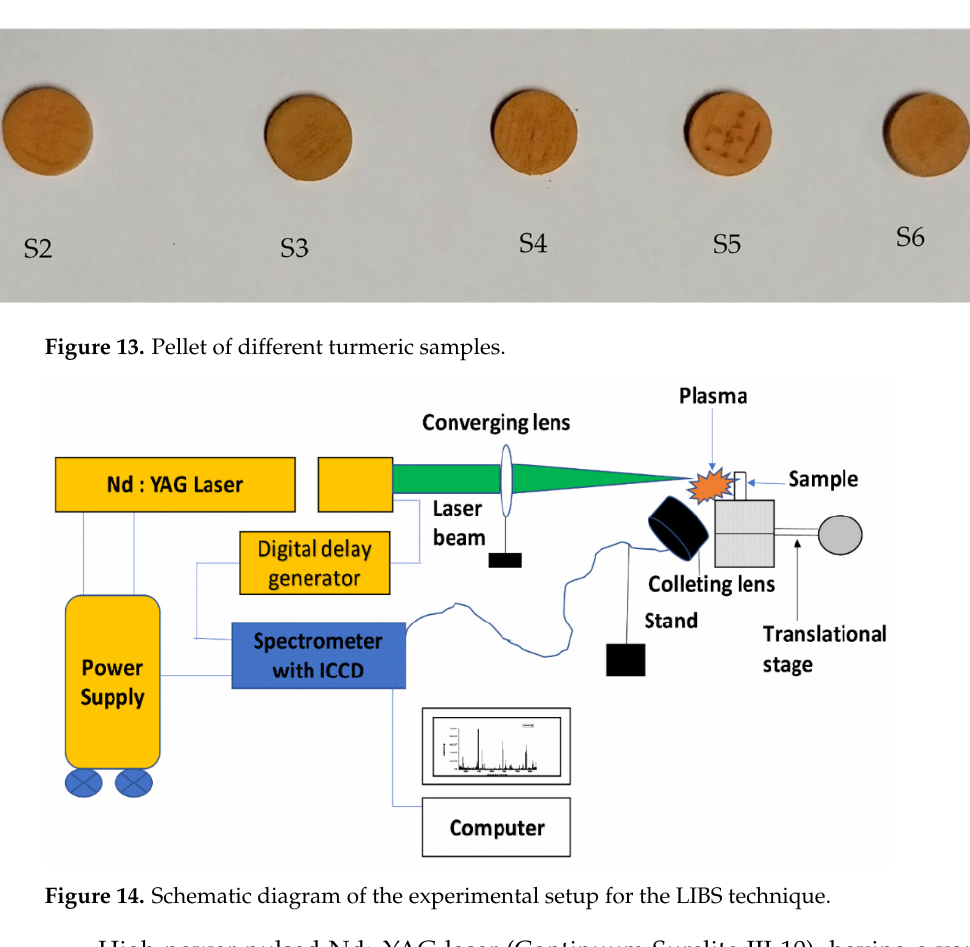
Figure 14. Schematic diagram of the experimental setup for the LIBS technique.